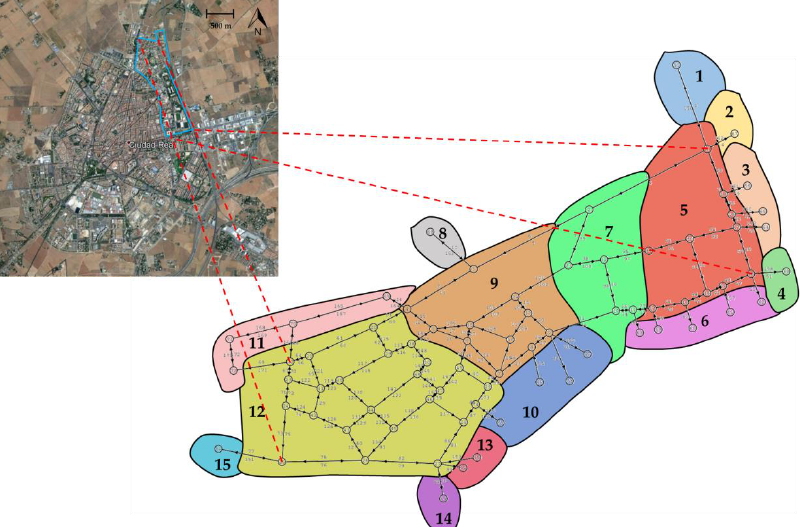
Figure 10. Traffic network to be modelled for analysis: Plan view of the urban area of Ciudad Real and the delimited Campus area to be modelled; Ciudad Real Campus network and its division in 15 traffic zones. Table 2. List of nodes on the traffic network and their associated zones.